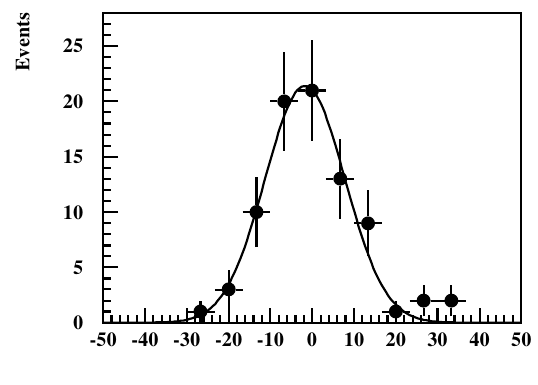
Figure 10. The distribution of ∆ φ between the azimuth angle estimated using the VRM and the corresponding angle estimated using the particle detector data. The distribution is fitted with Gaussian function of sigma equal to 9.6